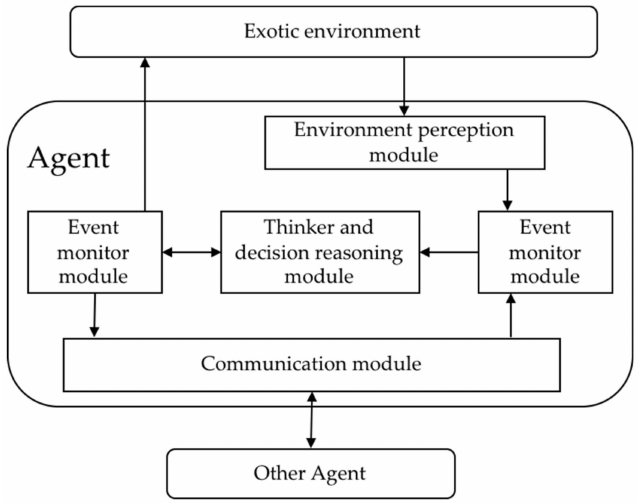
Figure 1. Agent structure